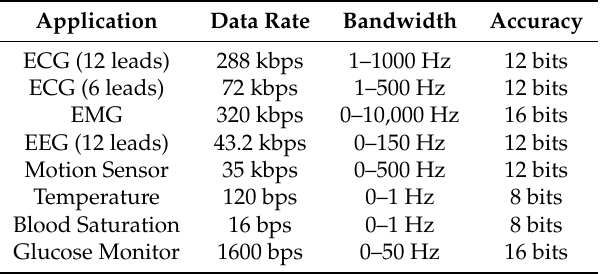
Table 1. Data transmission rates for several Wireless Body Area Network (WBAN) devices, adapted from